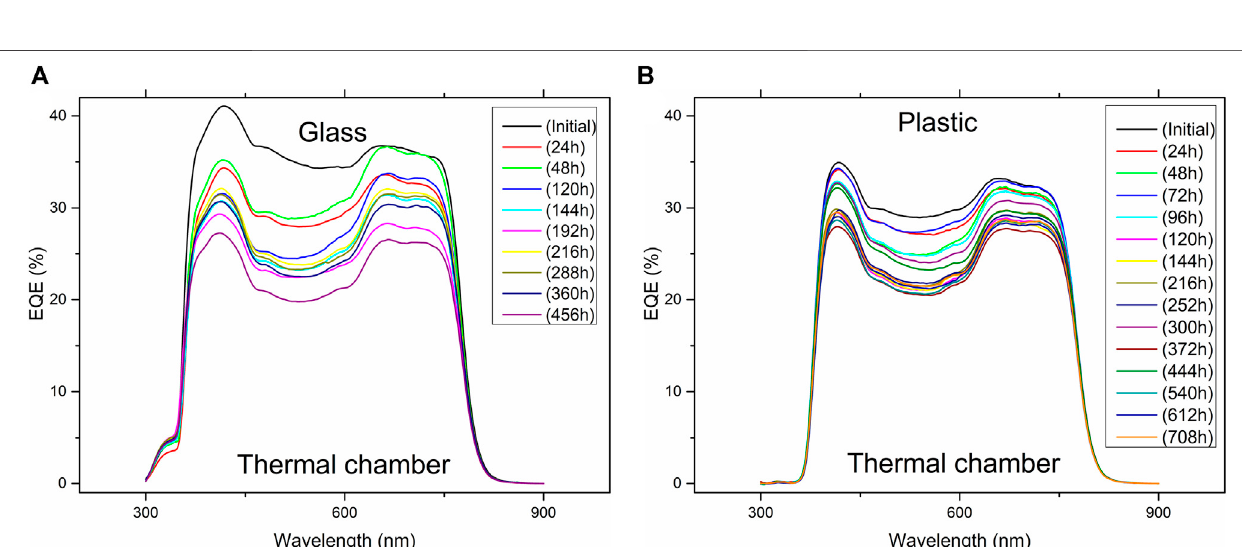
Frontiers in Energy Research |